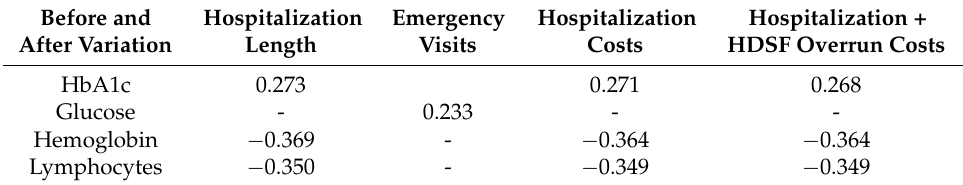
Table 3. Statistically significant correlations between quantitative